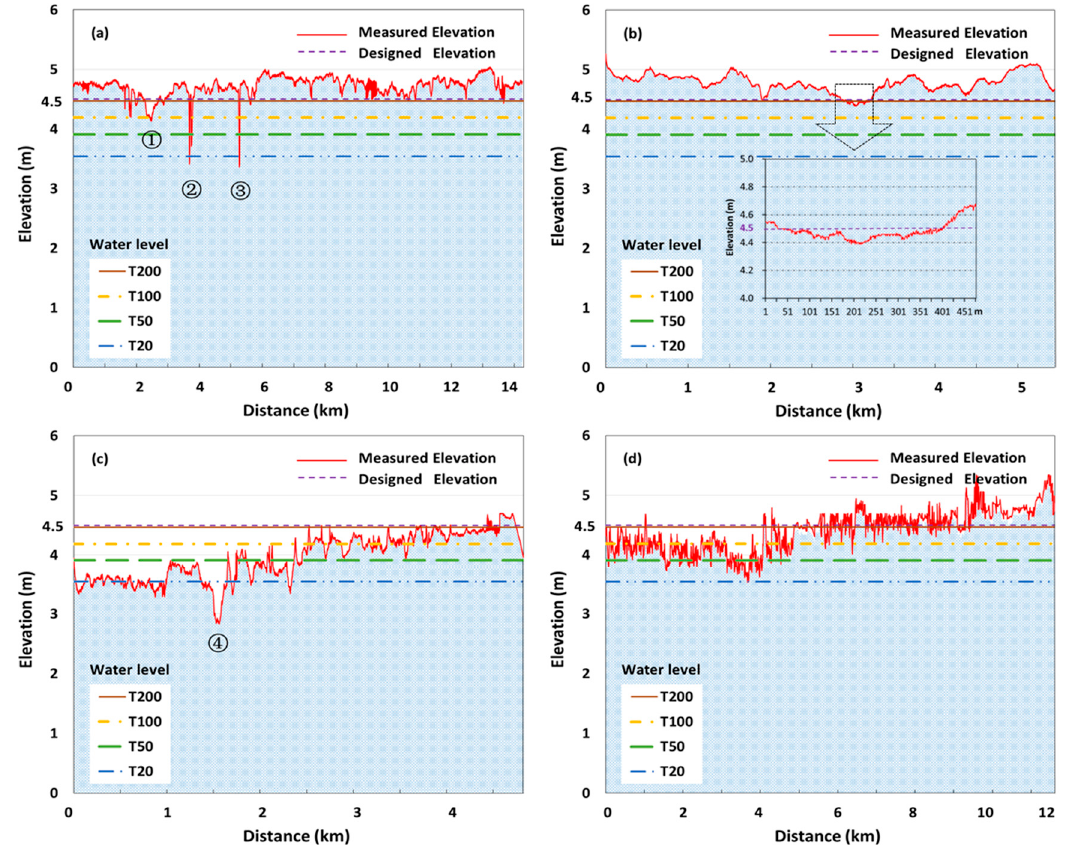
Figure 9. Comparison of the continuous crown elevation from the 0.5 m grid DEM against the designed elevation and the extreme water levels in the four return periods of 20, 50, 100 and 200 years for levees A ( a ), B ( b ), C ( c ) and D ( d ). The distance starts from the west within each levee.